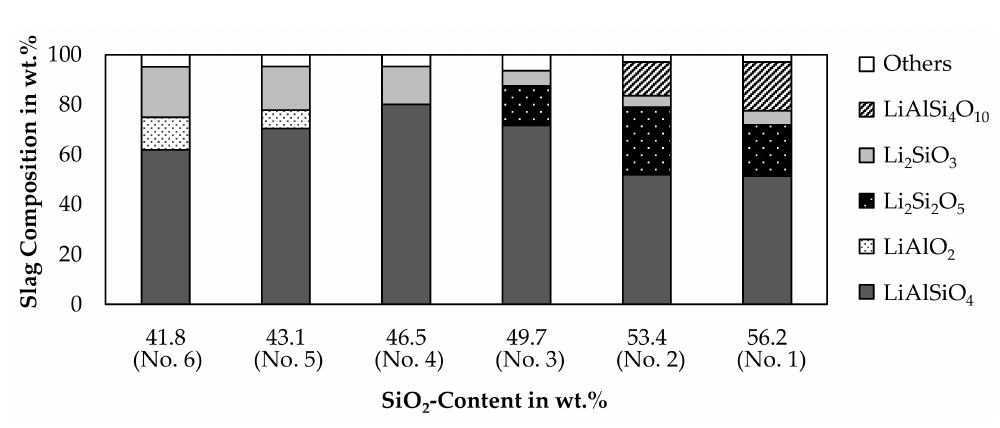
Figure 15. Simulated mineralogical composition of the slag in